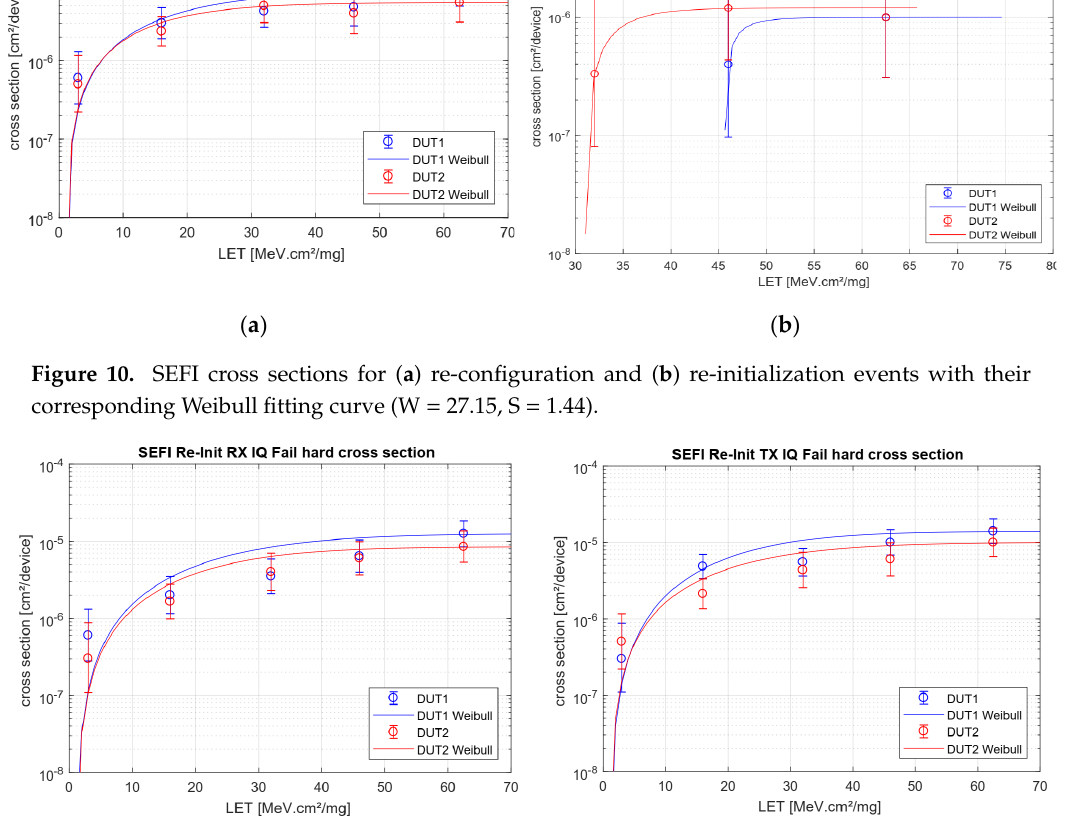
Figure 11. SEFI cross sections for re-initialization events based on ( a ) hard IQ failures on the receiver chain and ( b ) hard IQ failures on the transmitter chain (W = 34.84, S = 1.743).